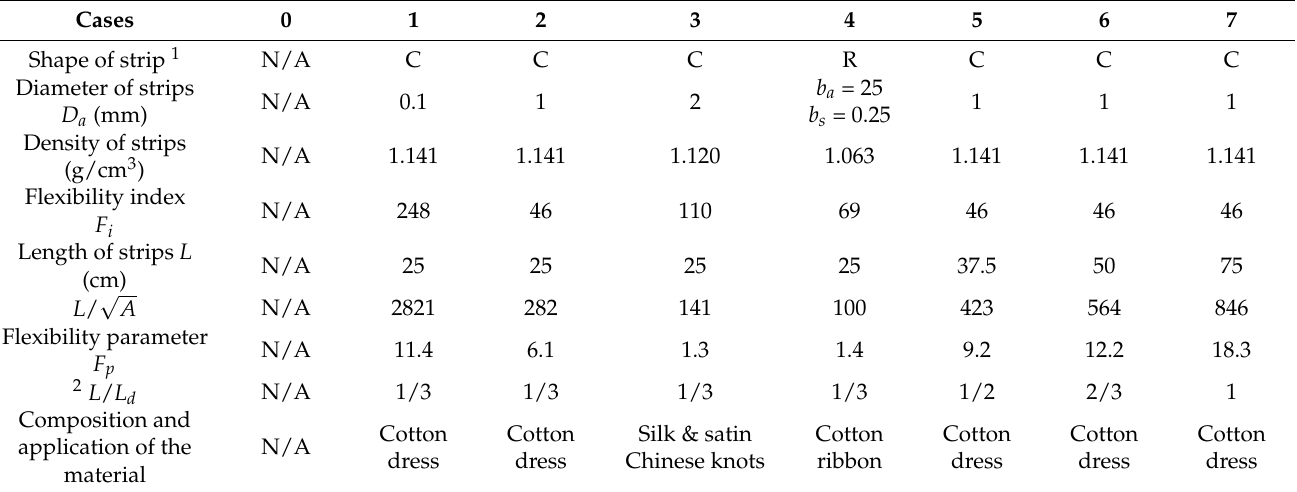
Table 3. Composition of CKAW and study cases.